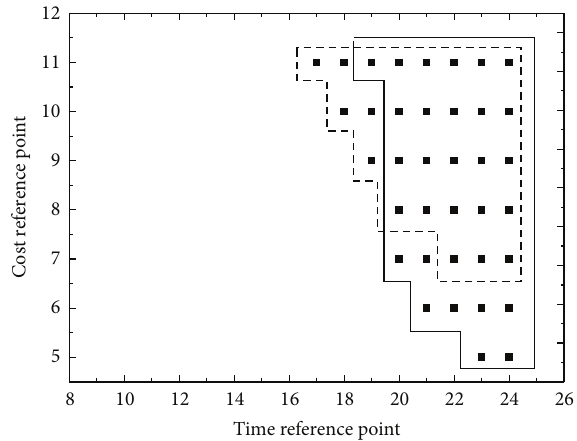
Figure 12: Possible reference points of carpooling success with traffic congestion rate 0.5.